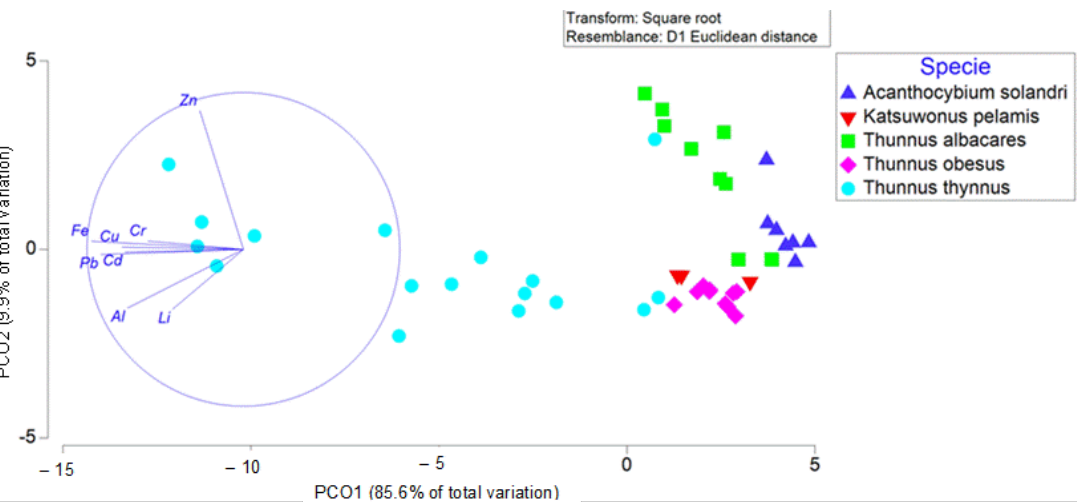
Figure 2. Principal component analysis (PCoA) based on Euclidean distances of square root trans- formed data of heavy metals and metal element content in the study species.